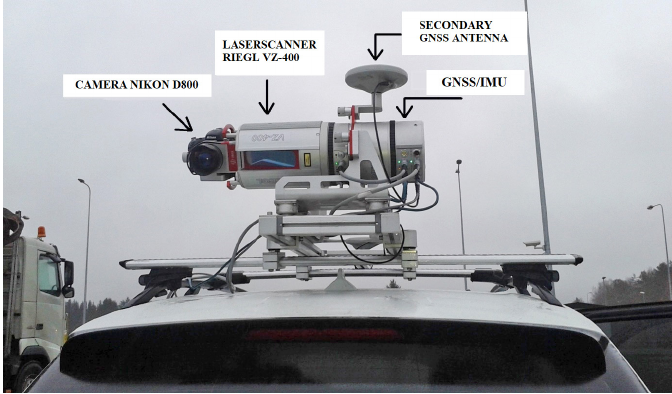
Figure 2. Installed onto the roof of the vehicle are a horizontally terrestrial laser scanner Riegl VZ-400, IMU/GNSS, secondary GNSS antenna and camera Nikon D800 (Kokamägi 2016 referred to in Annok,